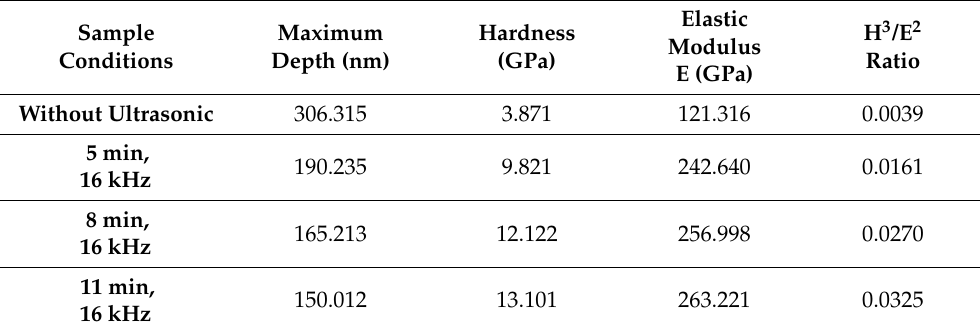
Figure 5. Load vs. displacement curve of TiN-coated samples after ultrasonic treatment at 16 kHz for 5, 8, and 11 min (extreme high condition). Table 1. Summary of output data from nanoindentation tests for ultrasonic treated samples at 16 kHz for different exposure times (extreme high PVD